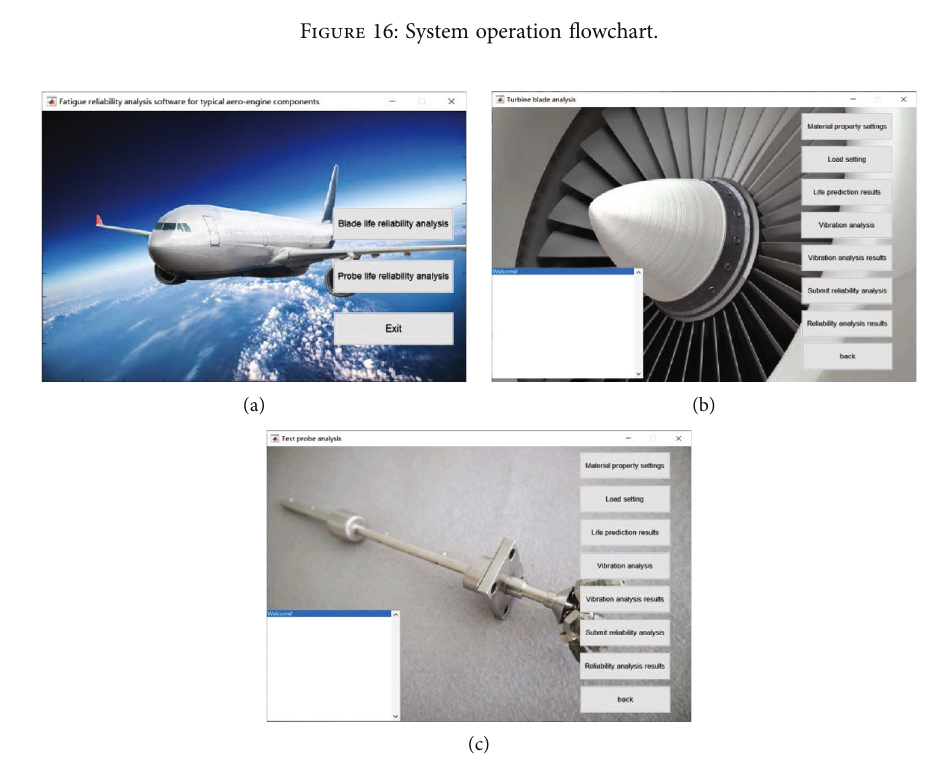
Figure 17: System